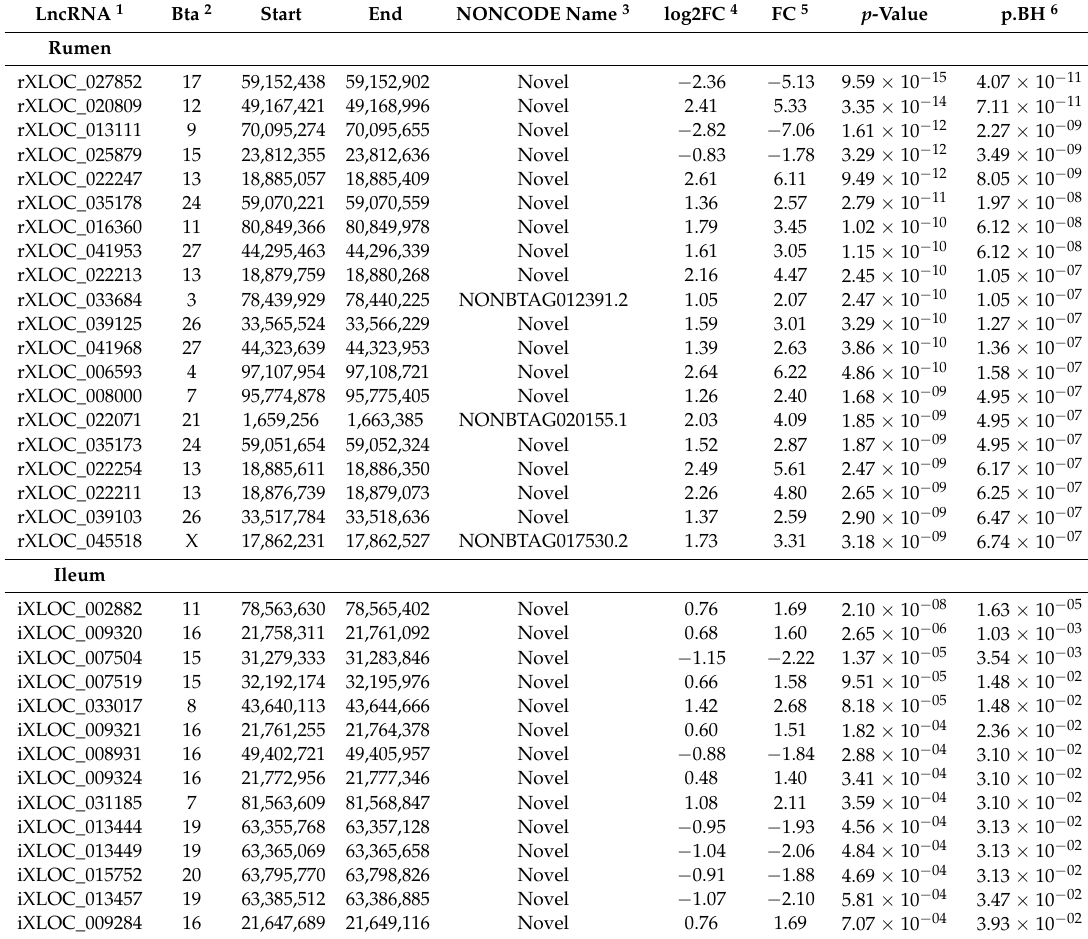
Table 2. Top significantly differentially expressed lncRNAs between day 33 (pre-weaning) and day 96 (post-weaning) in rumen and ileum